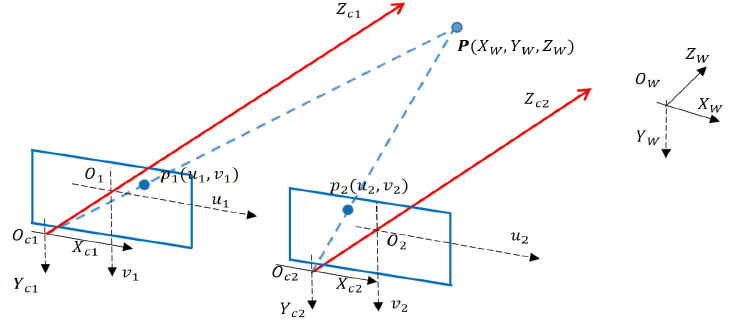
Figure 4. Imaging schematic diagram of binocular